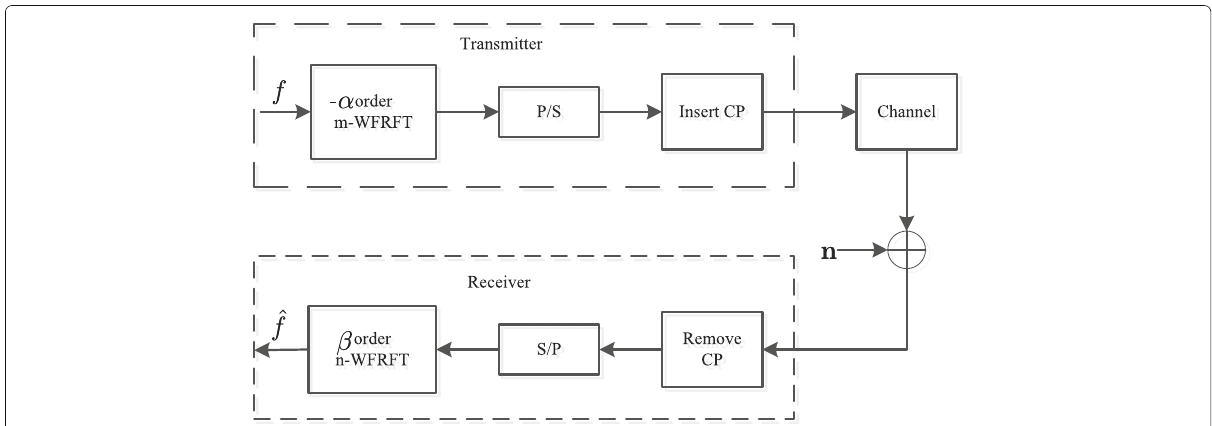
Fig. 2 The generalized hybrid carrier modulation (GHCM)